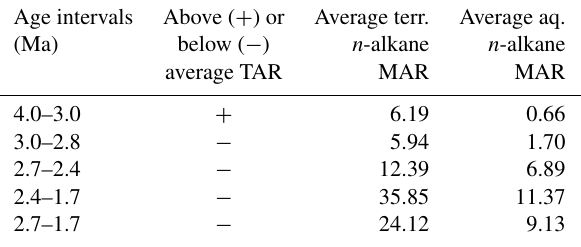
Table 2. Comparisons between average TAR and terrigenous and aquatic n -alkane mass accumulation rates across key climatic intervals at 4.0–3.0, 3.0–2.8, 2.7–2.4, and 2.4–1.7Ma. Overall above ( + ) and below ( − ) 4–1.7Ma TAR average values and terrigenous and